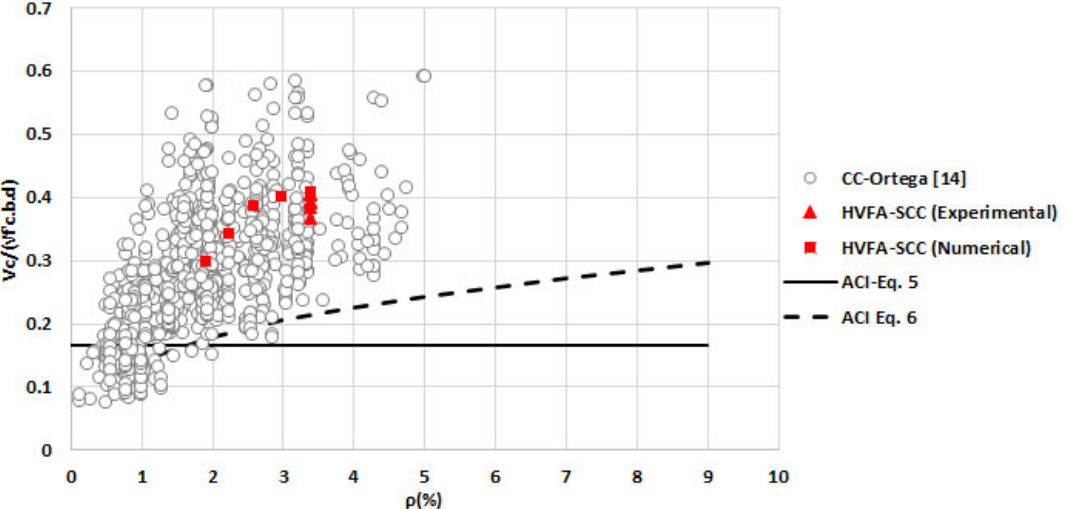
Figure 18. HVFA ‐ SCC shear strength in the database of normalized shear strength vs. longitudinal reinforcement ratio.